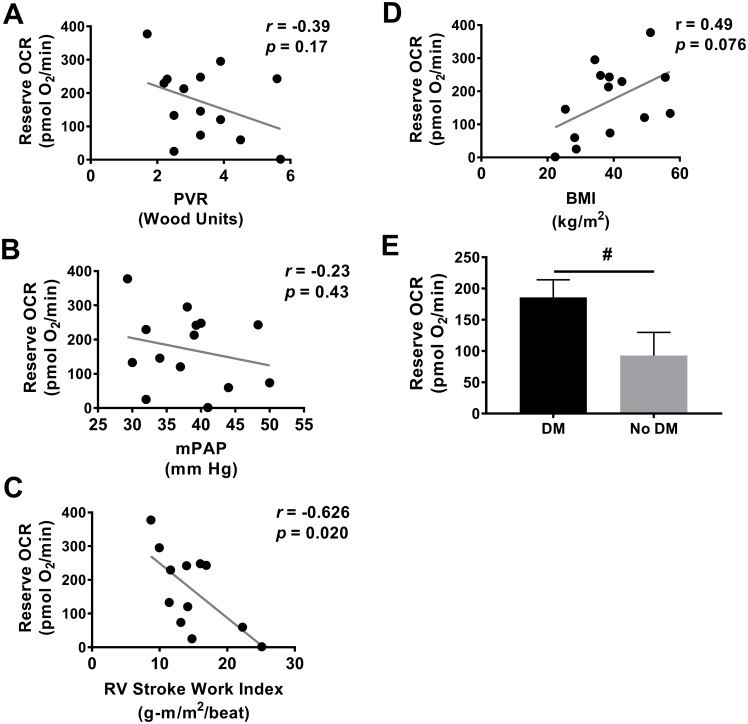
Group 2 PH platelet bioenergetics correlates with RV dysfunction.Pearson’s correlation of platelet reserve oxygen consumption rate with (A) pulmonary vascular resistance (PVR), (B) mean pulmonary artery pressure (mPAP), (C) right ventricular stroke work index (RV SWI), (D) body mass index (BMI). (E) Platelet reserve oxygen consumption rate in subject with and without diabetes mellitus (DM). Data are mean ± SEM. Unpaired 2-tailed t-test used to compare groups, #p < 0.1.